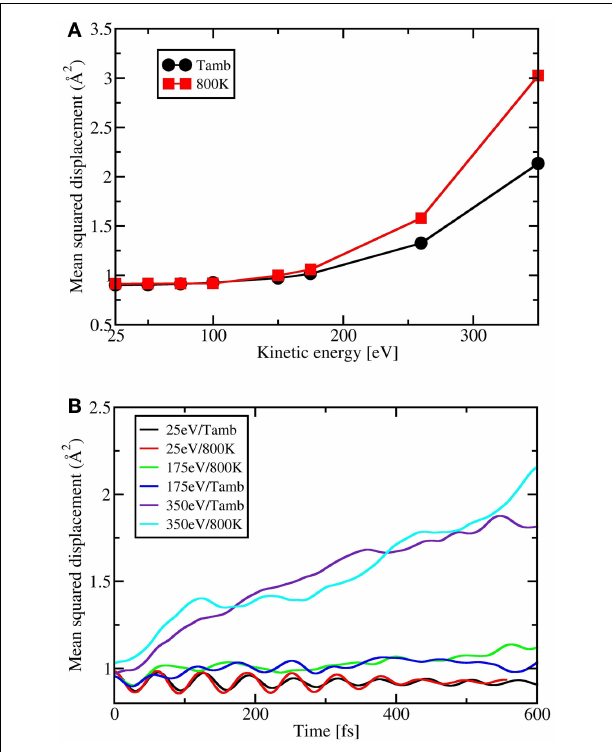
FIGURE 7 | (A) Mean square displacement (Å 2 ) of C 60 carbon atoms as a function of impinging C 60 kinetic energy (eV) for two different temperatures (K). (B) Mean squared displacement (Å 2 ) of C 60 carbon atoms as a function of time (fs) parameterized as a function of the impinging C 60 kinetic energy